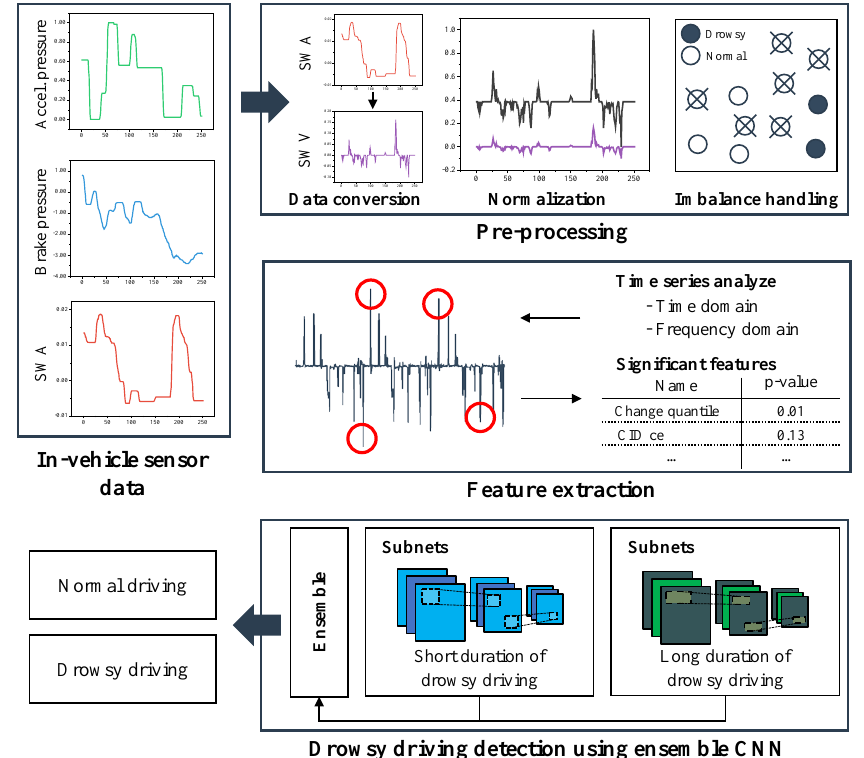
Figure 3. Overall process of the drowsy driving detection